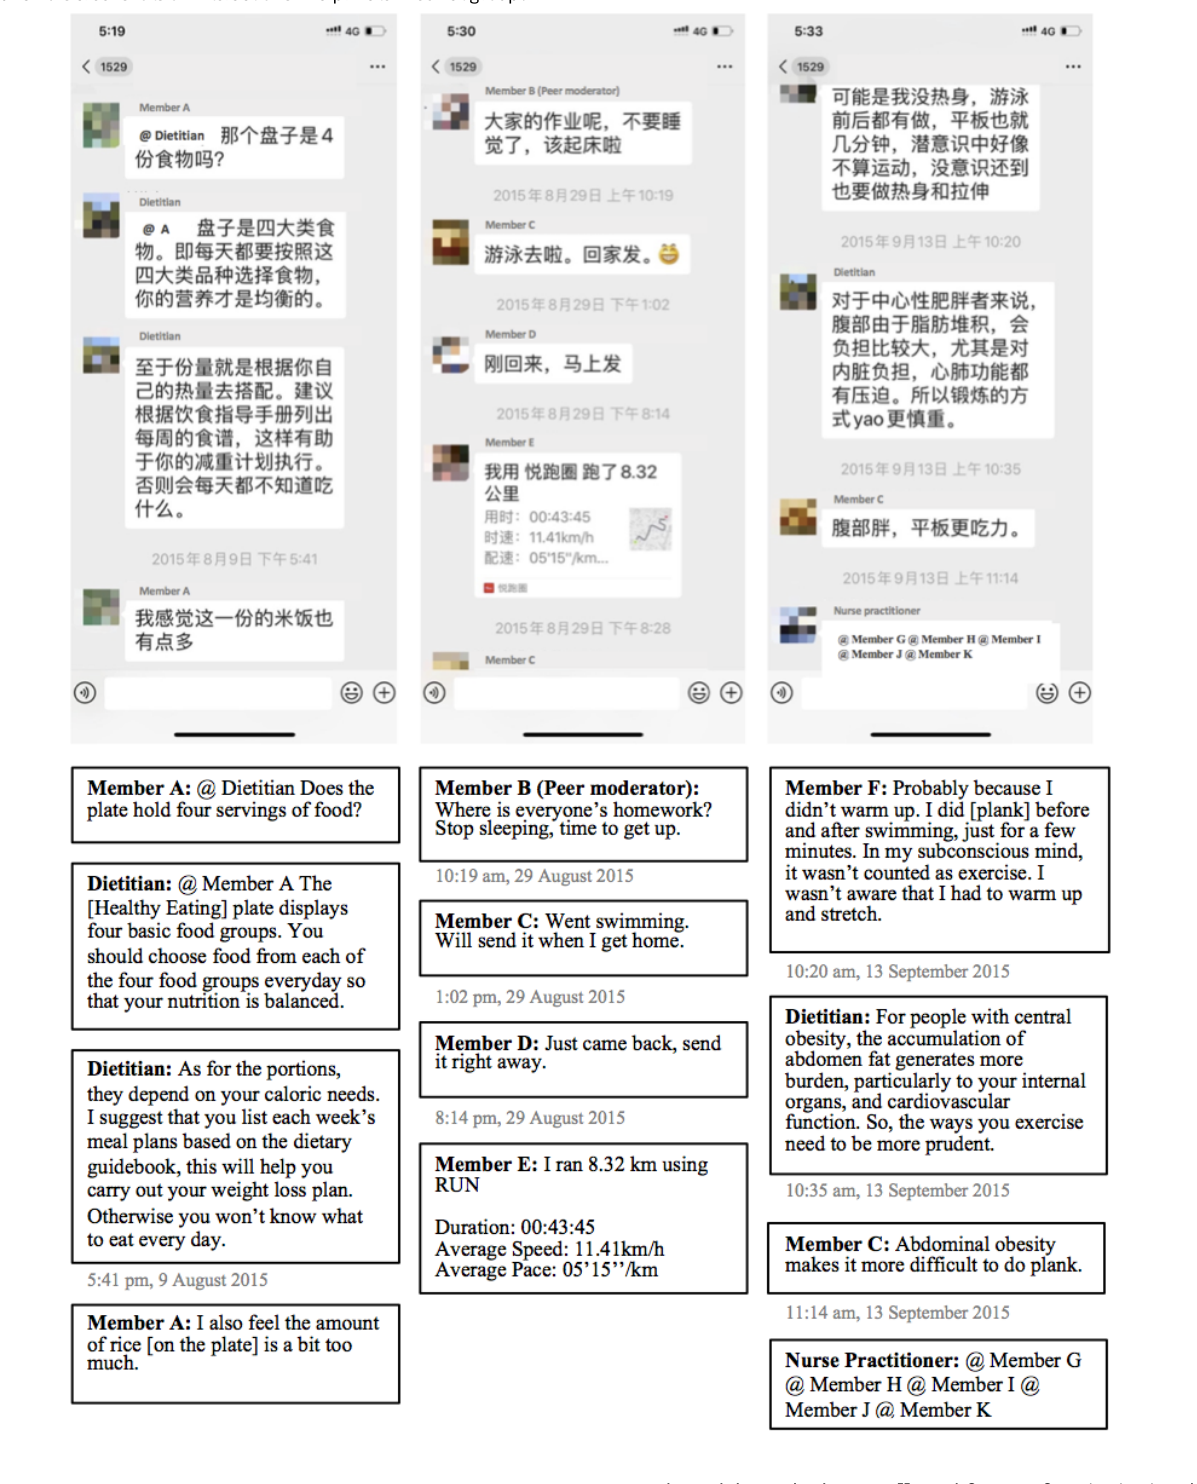
Figure 1. Screenshots of interactions in a private WeChat